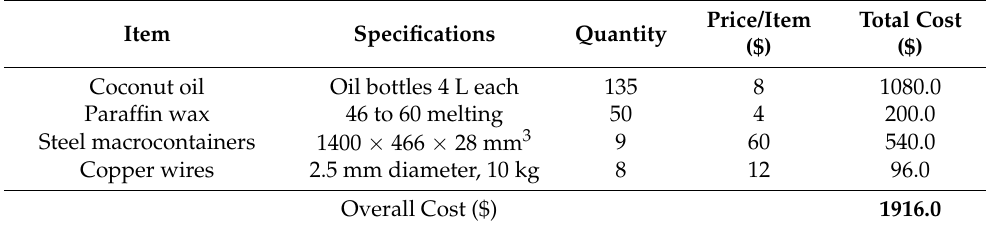
Table 7. PCMs and macro-containers economical study adressing their specifications and their respective